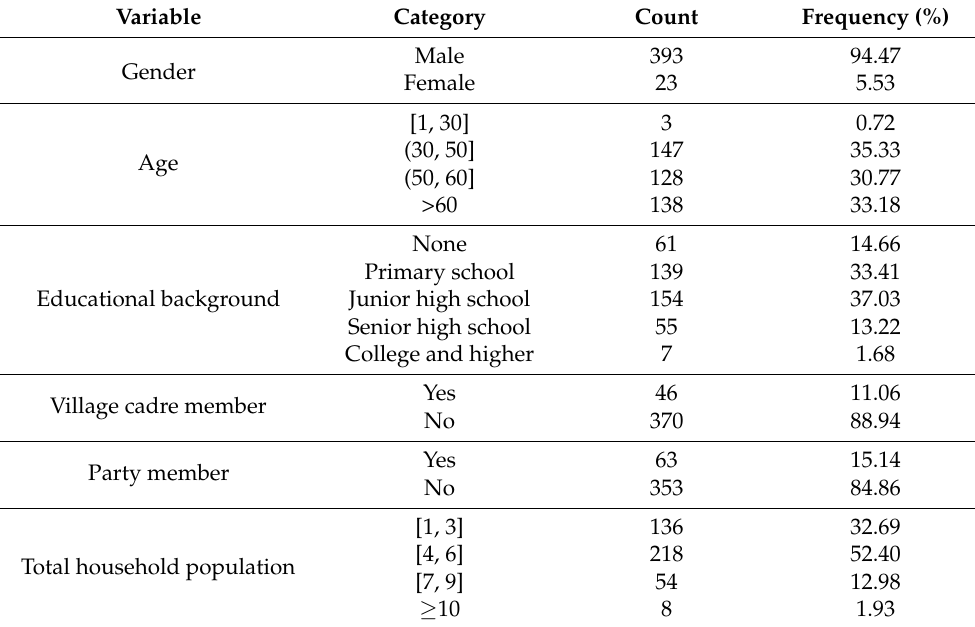
Table A1. Basic characteristics of interviewed